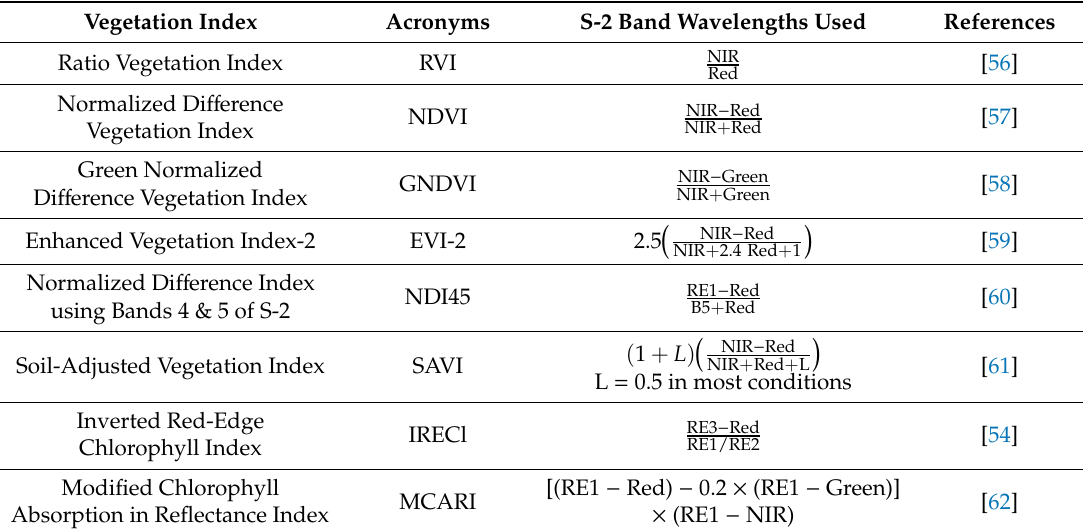
Table 3. List of the vegetation indices used in the current